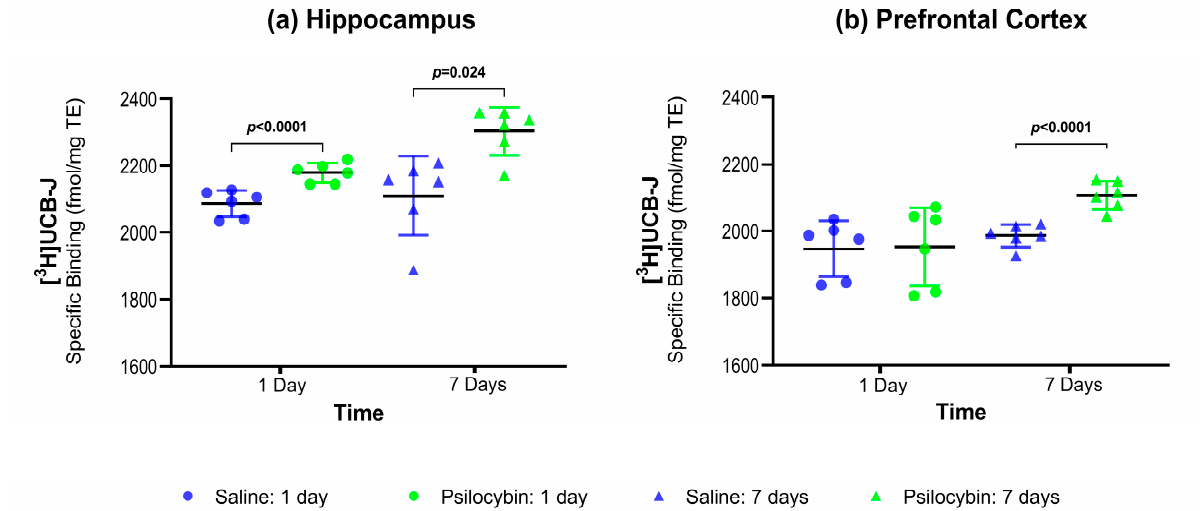
Figure 1. Group-wise comparisons of synaptic vesicle protein 2A (SV2A) density (mean ± SD) in the hippocampus ( a ) and prefrontal cortex (PFC) ( b ) as measured with [ 3 H]UCB-J autoradiography. Table 1. Group-wise summary of statistical tests performed for each radioligand. All tests show the adjusted p -values using the Holm method. NA (not applicable) indicates test was not performed. Hippocampus Prefrontal Cortex 1